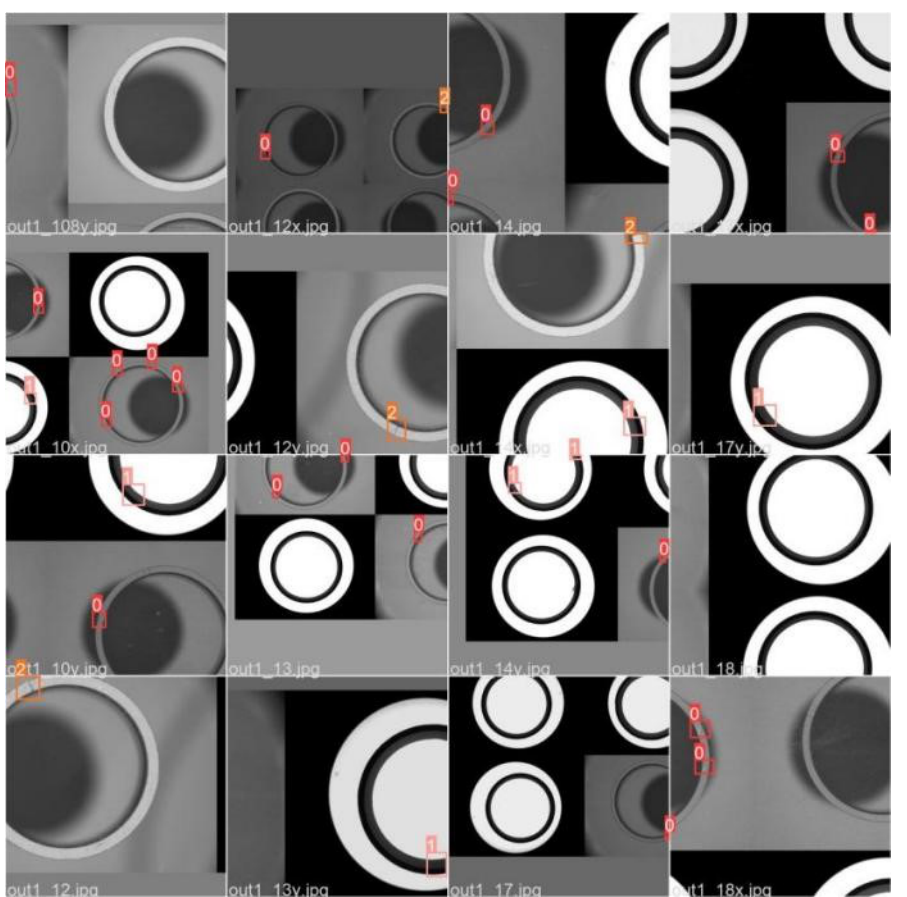
Figure 8. The training examples of Mosaic data